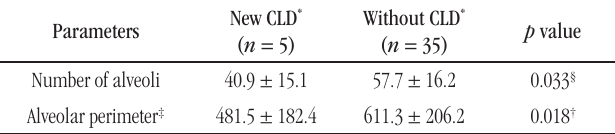
in the “without” CLD and “new” CLD groups